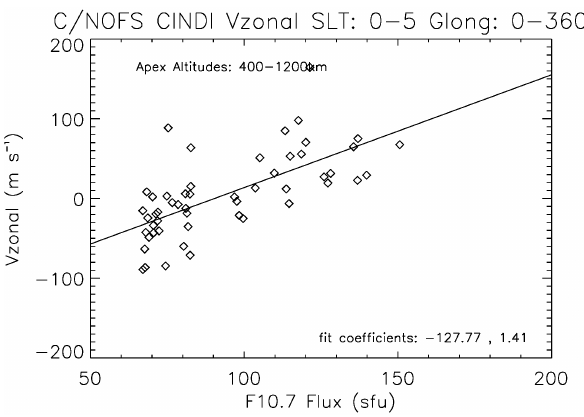
462 Figure 8. Similar to Figure 7 except for the 0–5 SLT range. 463 464 Fig. 8. Similar to Fig. 7 except for the 00:00–05:00SLT 465